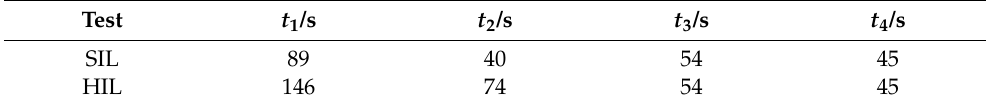
Table 6. Typical values of test